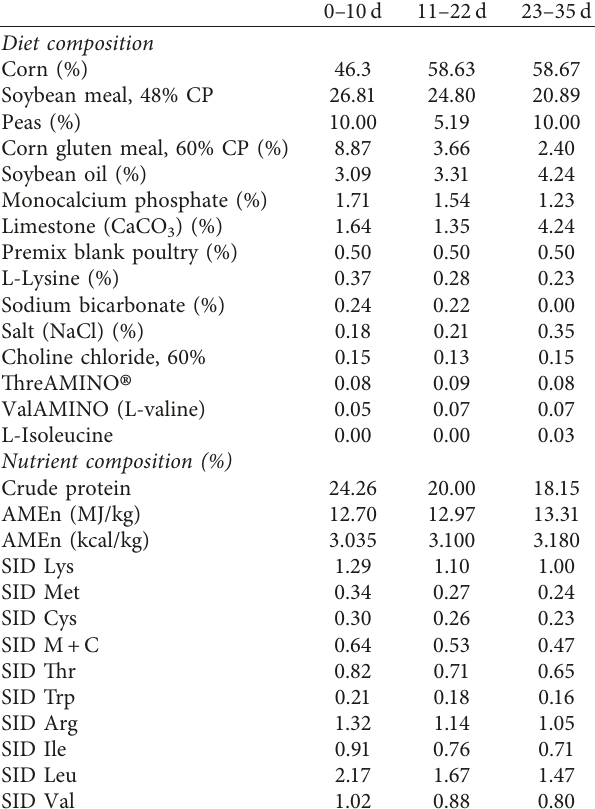
Table 1: Feeding composition of the basal